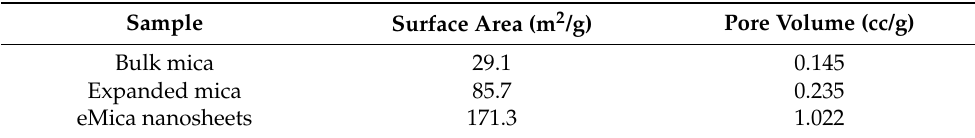
Table 1. Values of BET surface area and pore volume.